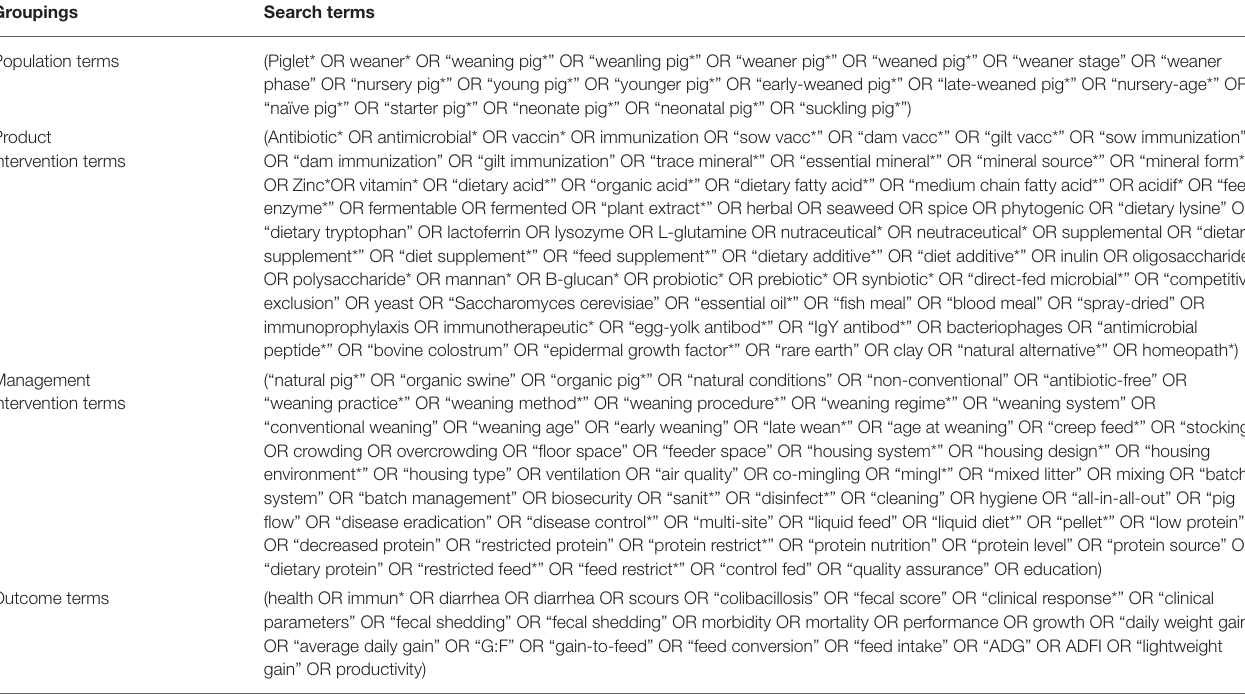
TABLE 2 | Search terms for non-antibiotic approaches to reduce the need for antibiotics in nursery pig production.